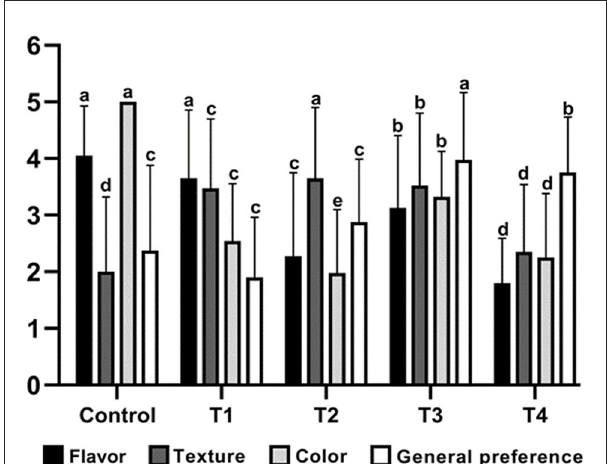
FIGURE6 Sensory preferences of ice cream samples. *a, b, c, d, e: Different letters for each sensory attribute indicate significant difference between treatments. Treatment 1: 15% M. indica and 5% M. dubia; Treatment 2: 15% M. indica and 10% M. dubia; Treatment 3: 20% M. indica and 5% M. dubia; Treatment 4: 20% M. indica and 10% M. dubia; Control: Commercial mango ice